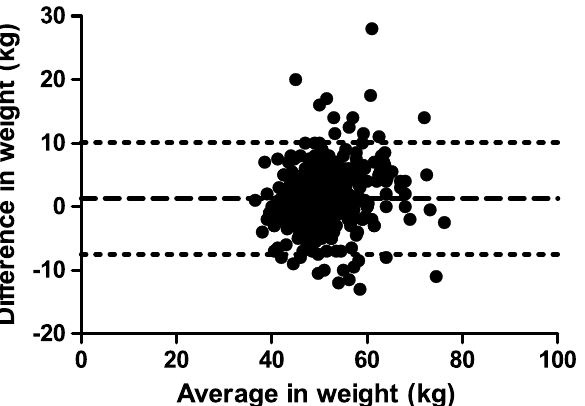
Figure 1. Bland–Altman plot of the difference between pre-gravid weight and 1st trimester weight measurement. Data shown as mean difference (dashed line) and 95% limits of agreement (dotted lines).